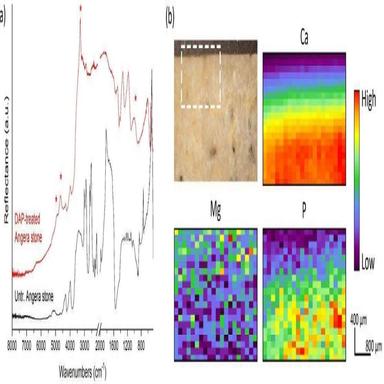
(a) ER-FTIR spectra collected on the surface of the Angera stone before (black pattern, untreated Angera stone) and after (red pattern, DAP-treated Angera stone) the application of the DAP consolidating poultice. The ∗ symbols point out the reflectance bands attributed to the formation of hydrated phosphates on the treated surface; (b) optical image of the polished cross-section of the DAP-treated Angera stone showing the region (dashed white rectangle) investigated by XRF and micro-XRF maps of calcium (Ca)